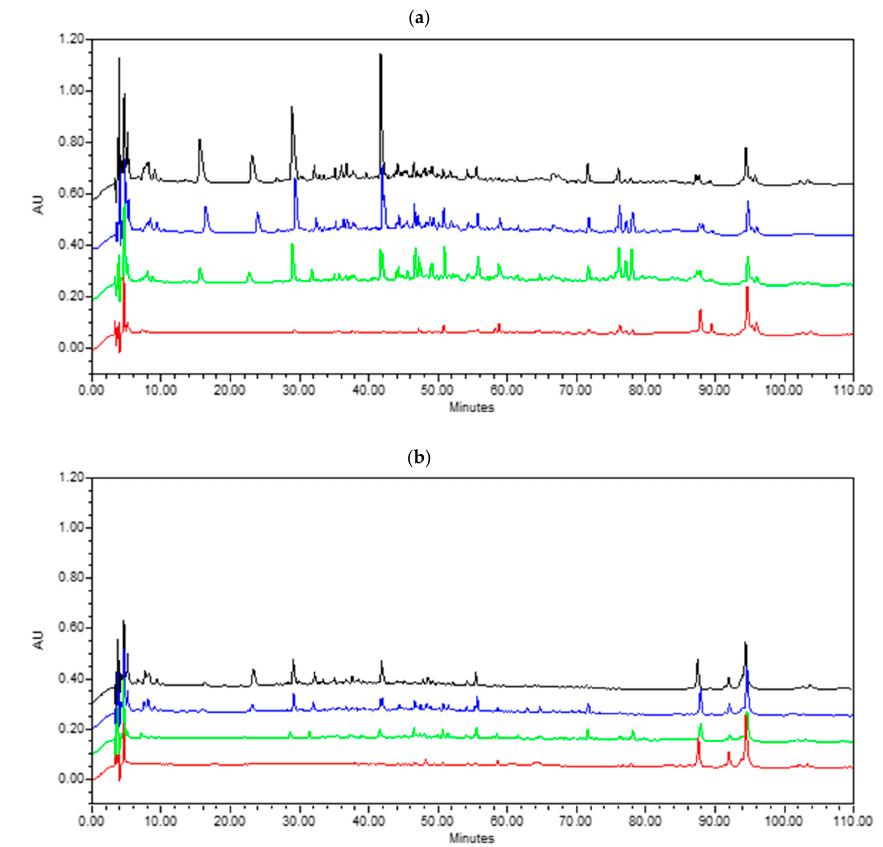
Figure 2. RP-HPLC chromatograms of water-soluble fractions of hard Xinotyri cheese made from raw ( a ) or pasteurized ( b ) milk, during ripening (colour black: 90 days, blue: 45 days, green: 20 days, red: 1 day)